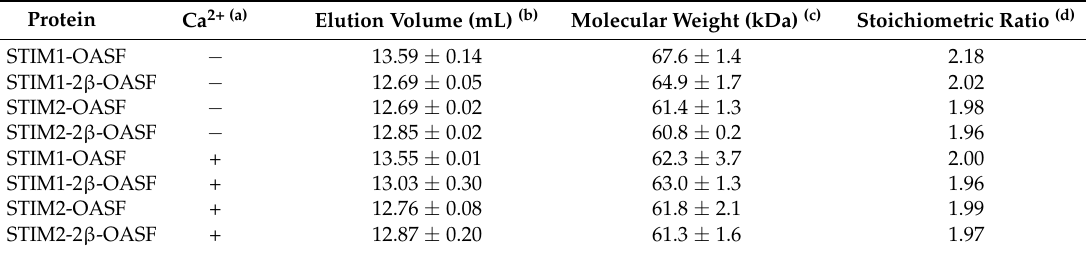
Table 1. Summary of STIM OASF SEC-MALS